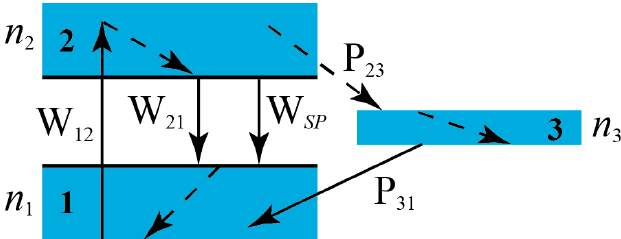
Figure 3. Scheme of the energy levels in a typical organic dye molecule. The arrows indicate different transitions in the excitation-deexcitation process. Dashed lines are purely non-radiative deexcitation.